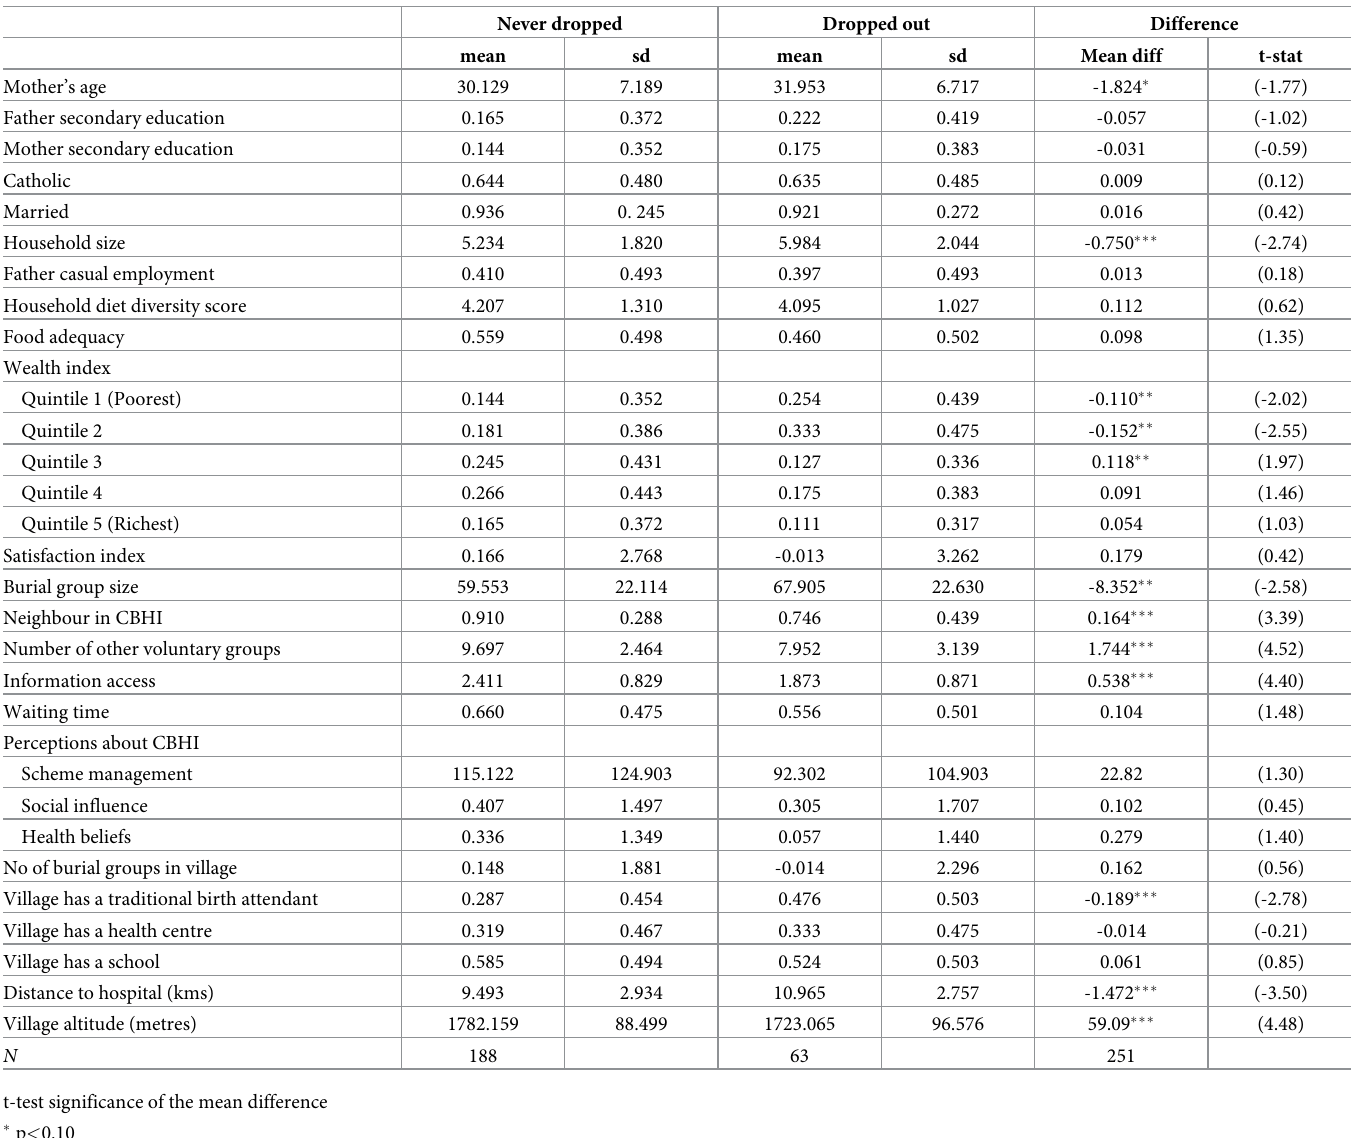
Table 1. Summary